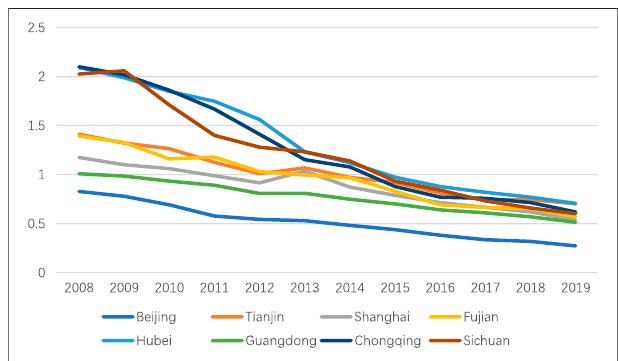
FIGURE 2 | Carbon intensity change of pilot areas.